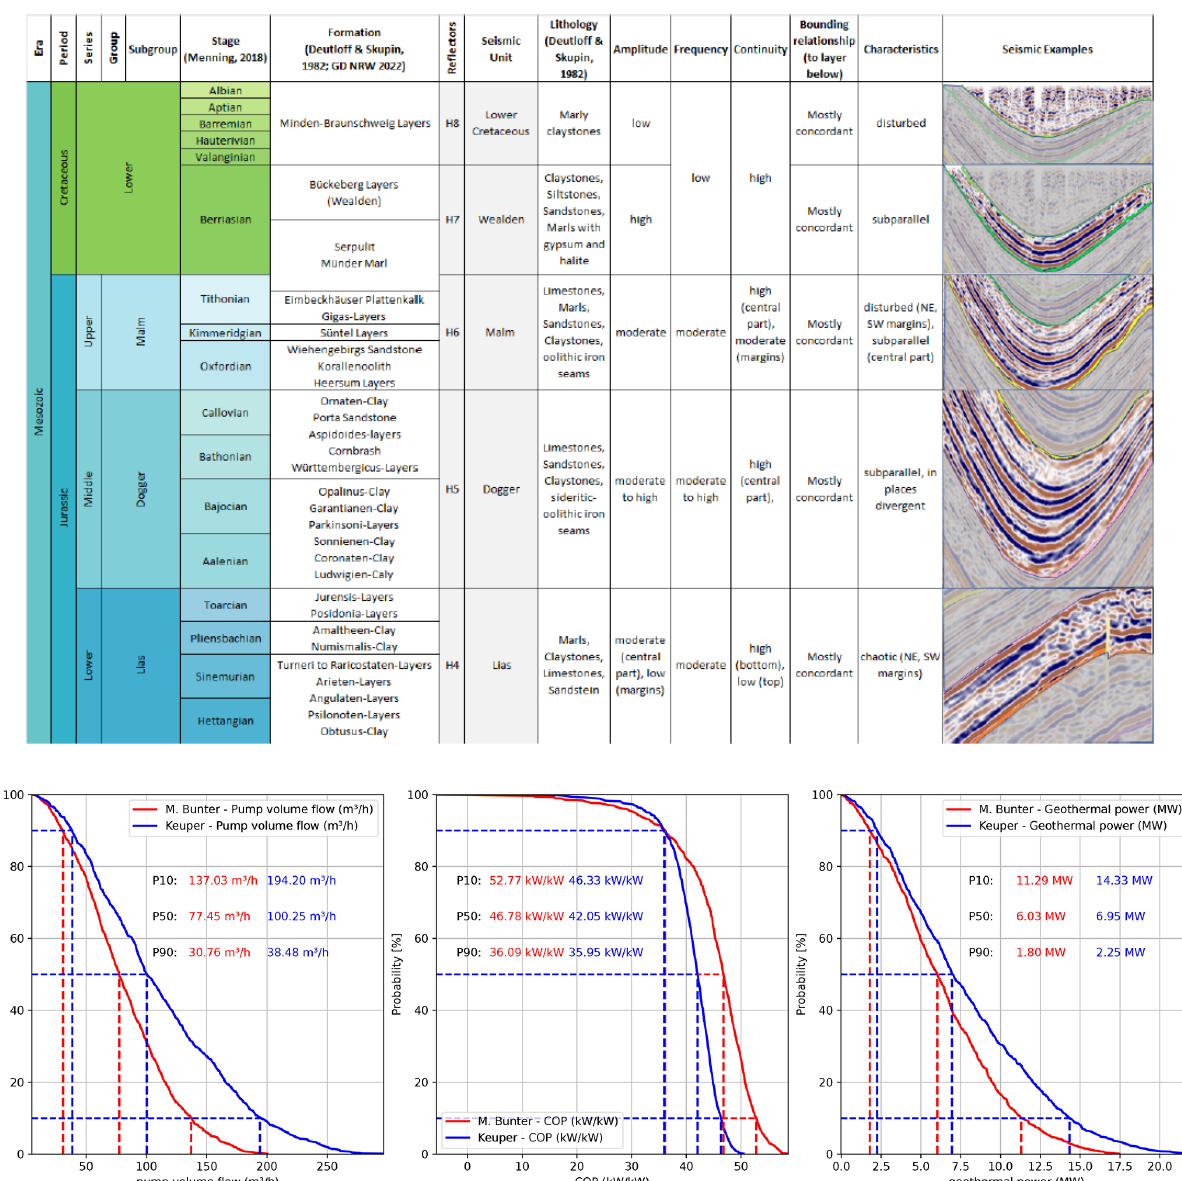
Figure 7. Stochastic simulations of pump volume flow, coefficient of performance, and geothermal power for the Keuper and Middle Bunter